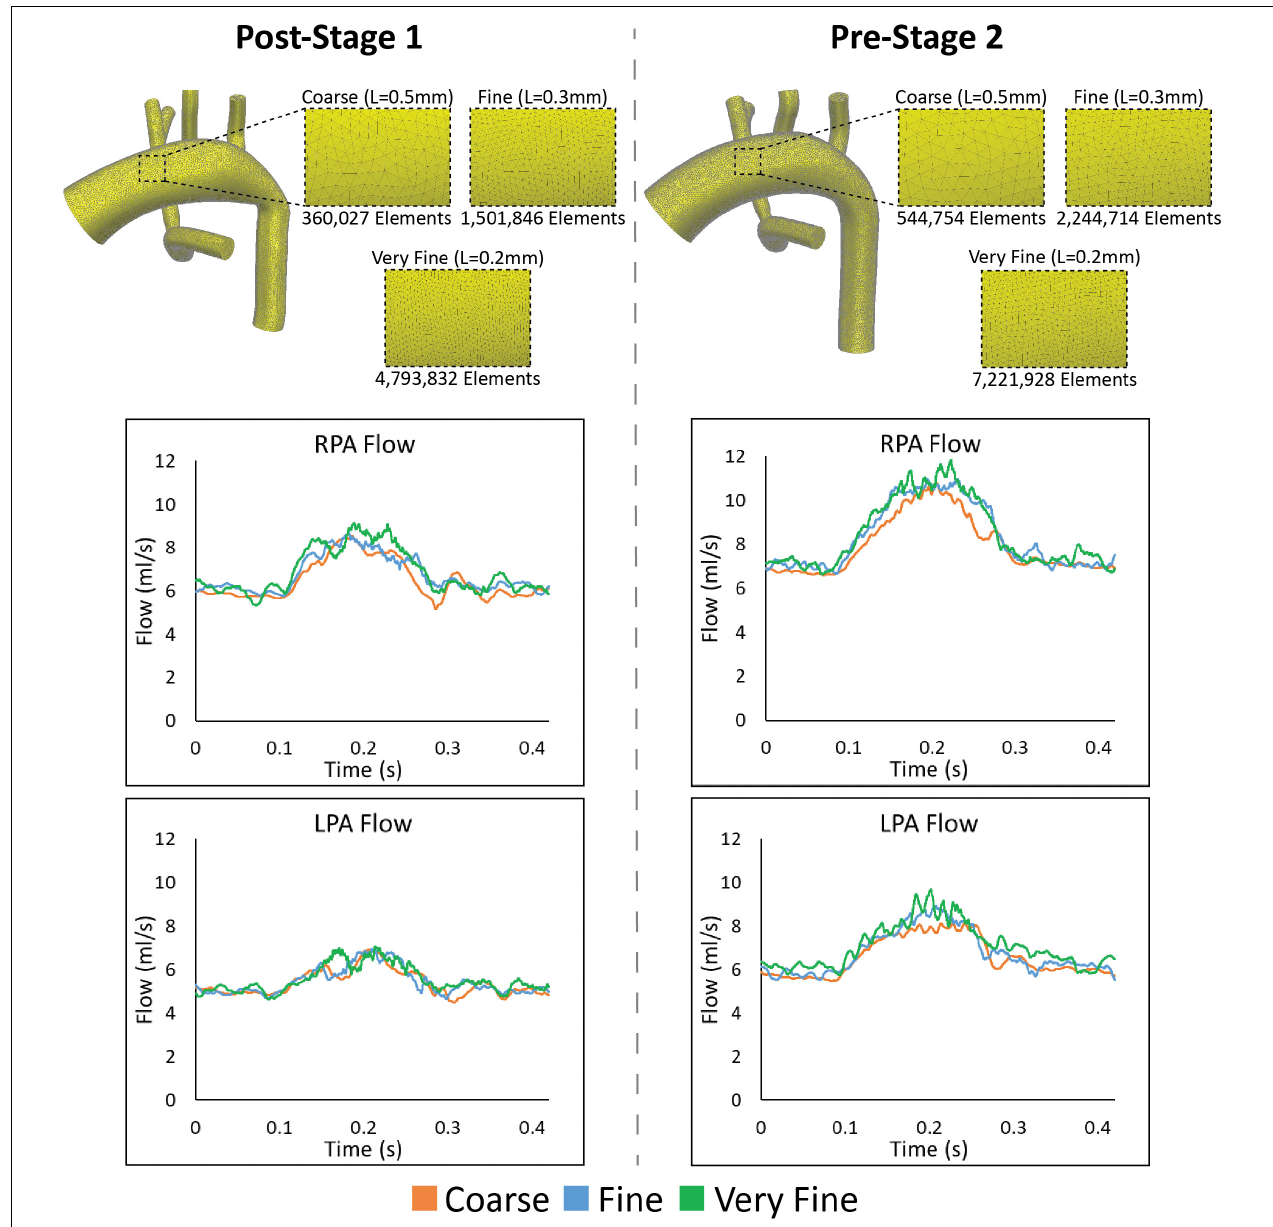
FIGURE 9 | Top: The various isotropic linear finite element meshes generated for the mesh-independence analysis for both Post-S1 and Pre-S2 models. Finer meshes are generated by incrementally decreasing the global element size (L). Bottom: Results from the mesh independence analysis. Flow at the LPA and RPA are plotted for both Post-S1 and Pre-S2 at each mesh size–coarse (orange), fine (blue), and very fine (green). As seen in each plot, there is little alteration in mean flow values in the PAs and the high-frequency oscillation is present in all cases.